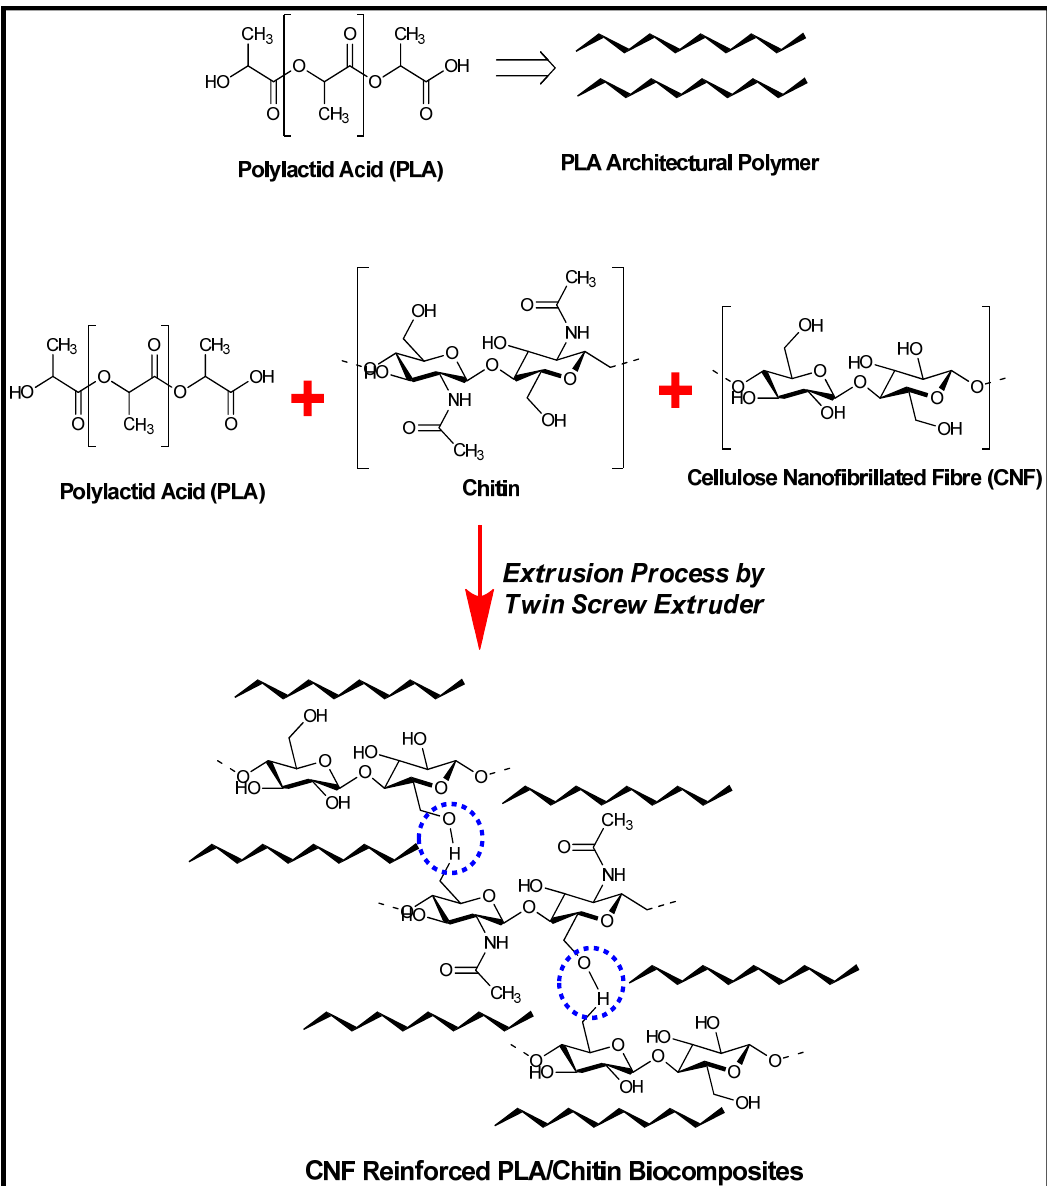
Figure 8. Schematic diagram of Possible chemical interaction between PLA, chitosan, and CNF